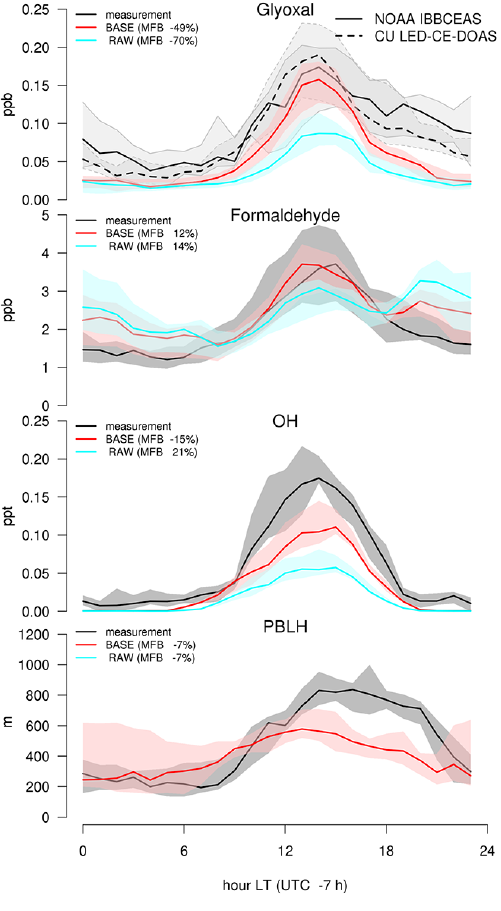
Figure 6. Averaged (29 May 00:00UTC–16 June 00:00UTC) diur- nal cycles of glyoxal, formaldehyde, OH and boundary layer height (PBLH) at the LA ground site with model results using the orig- inal (RAW, blue) and updated emissions inventory (BASE, red). Glyoxal has been measured by two instruments at the LA ground site which are shown separately: Incoherent Broad Band Cavity En- hanced Absorption Spectroscopy (IBBCEAS) (Washenfelder et al., 2008) and University of Colorado at Boulder Light Emitting Diode Cavity Enhanced Differential Absorption Spectroscopy (CU LED- CE-DOAS) (Thalman and Volkamer, 2010).